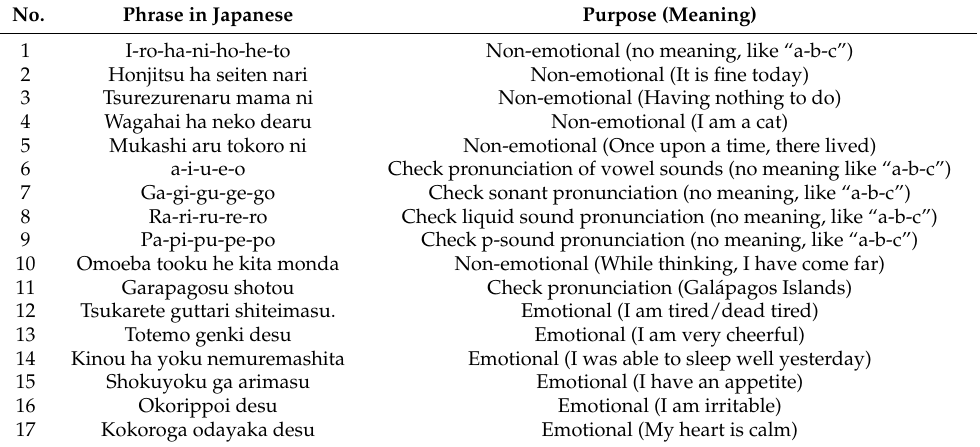
Table 2. Seventeen phrases used for